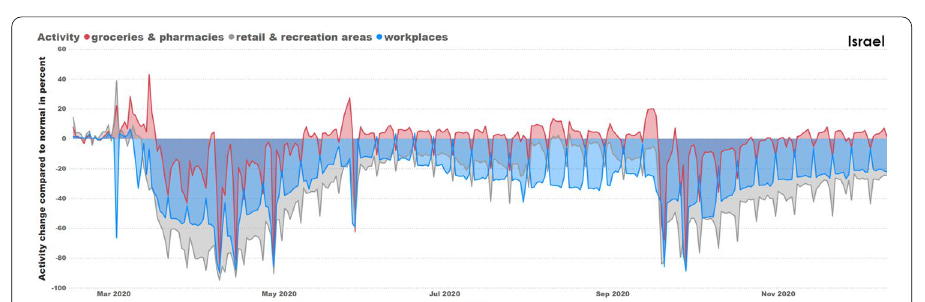
Fig. 17 Two main with additional short duration drop in activity